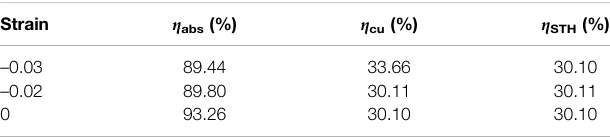
TABLE 1 | Energy conversion ef fi ciency of light absorption, carrier utilization, and the solar-to-hydrogen ef fi ciency of the MP vdW heterostructure under the external